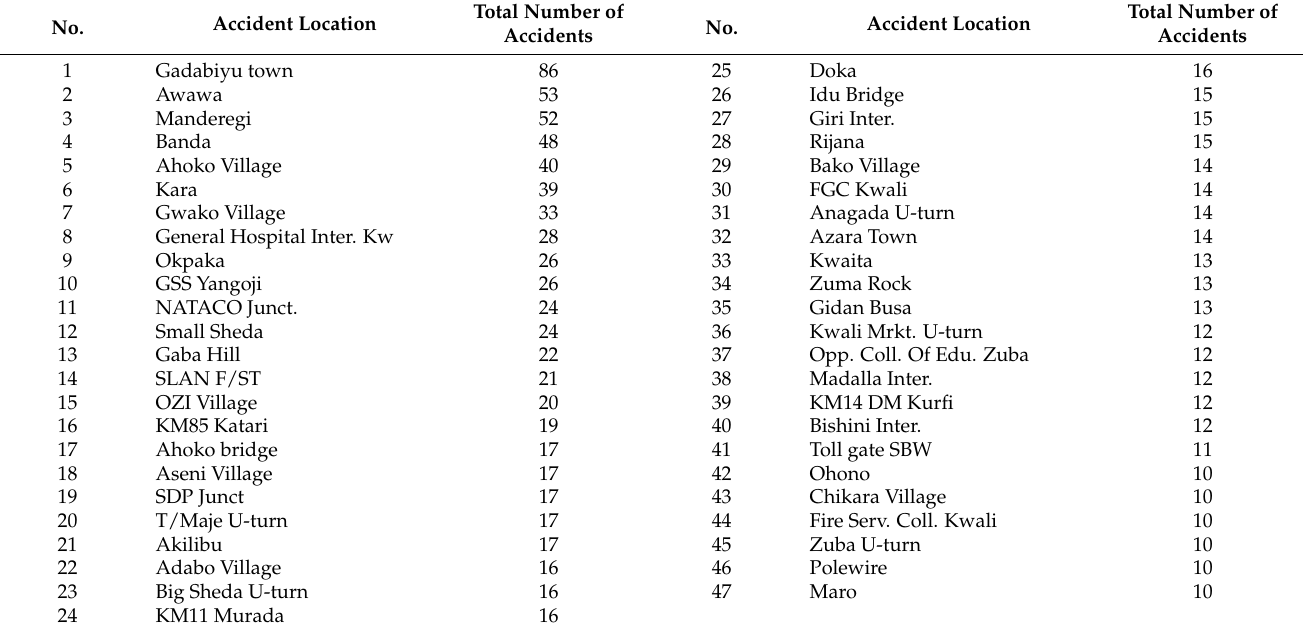
Table 3. Northbound locations with number of accidents of 10 or more